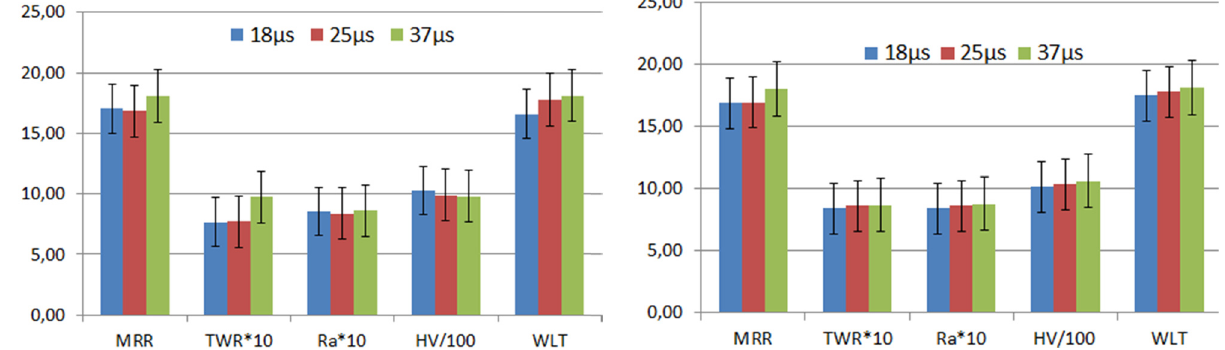
Figure 3: E ff ect of T on on performance measures. Figure 4: E ff ect of pulse o ff time on performance